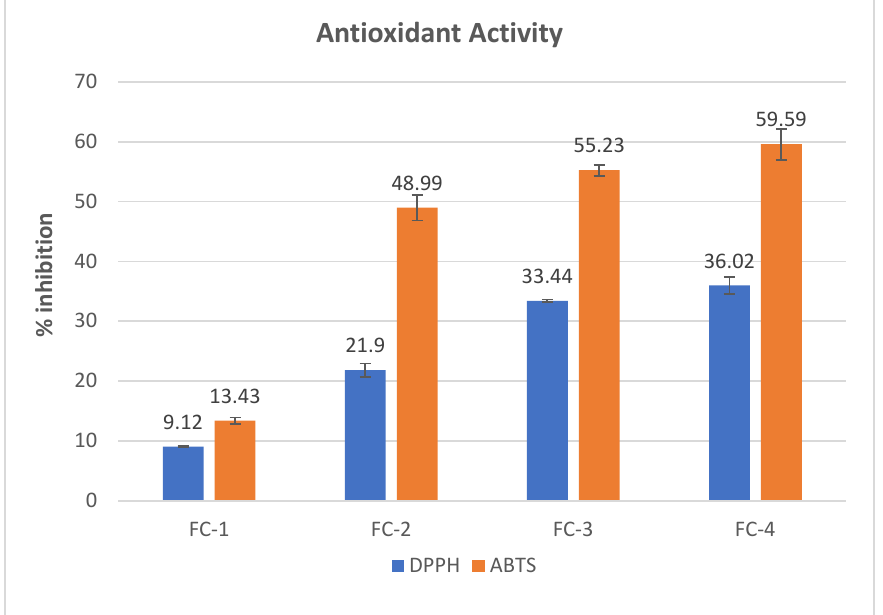
Figure 5. Antioxidant properties of the CS–SA-based edible films; control or FC-1, CS+ SA; FC-2, CS+ SA+ FFE (0.5%); FC-3, CS+ SA+ FFE (1%); and FC-4 CS+ SA+ FFE (1.5%).